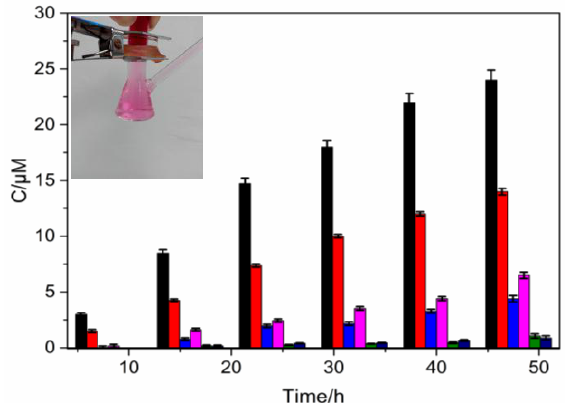
Figure 2. The percutaneous absorption of hair dyes. 0.3% (the largest amount without oxidants) and 0.15% (mixed with oxidants) for FB, 0.5% (the largest amount without oxidants) and 0.25% (mixed with oxidants) for VBB, and 0.4% (the largest amount without oxidants) and 0.2% (mixed with oxidants) for BR2, respectively. ( n = 3).